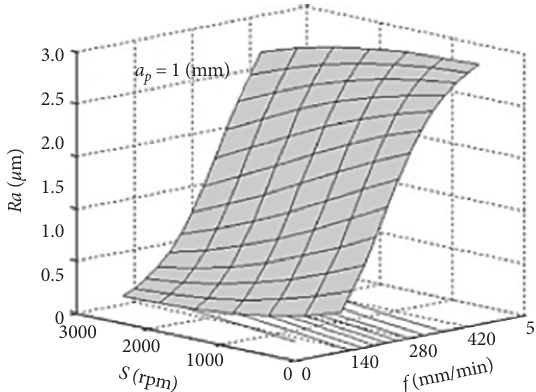
Figure 15: Influence of feed rate and spindle speed on Ra for constant doc of 1 mm.